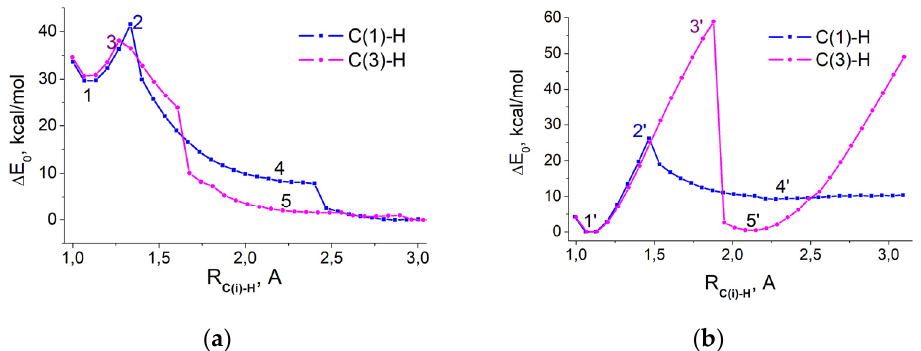
Figure 2. The energy relaxed surface scans of proton detachment from C 1 (blue) and C 3 (purple) carbons in: ( a ) RuBP1 + ⋅ H 2 O; E 0 = − 48,530.12 eV ( − 1,119,104.57 kcal/mol). ( b ) RuBP2 + ⋅ H 2 O; E 0 = − 48,531.77 eV ( − 1,119,142.62 kcal/mol).